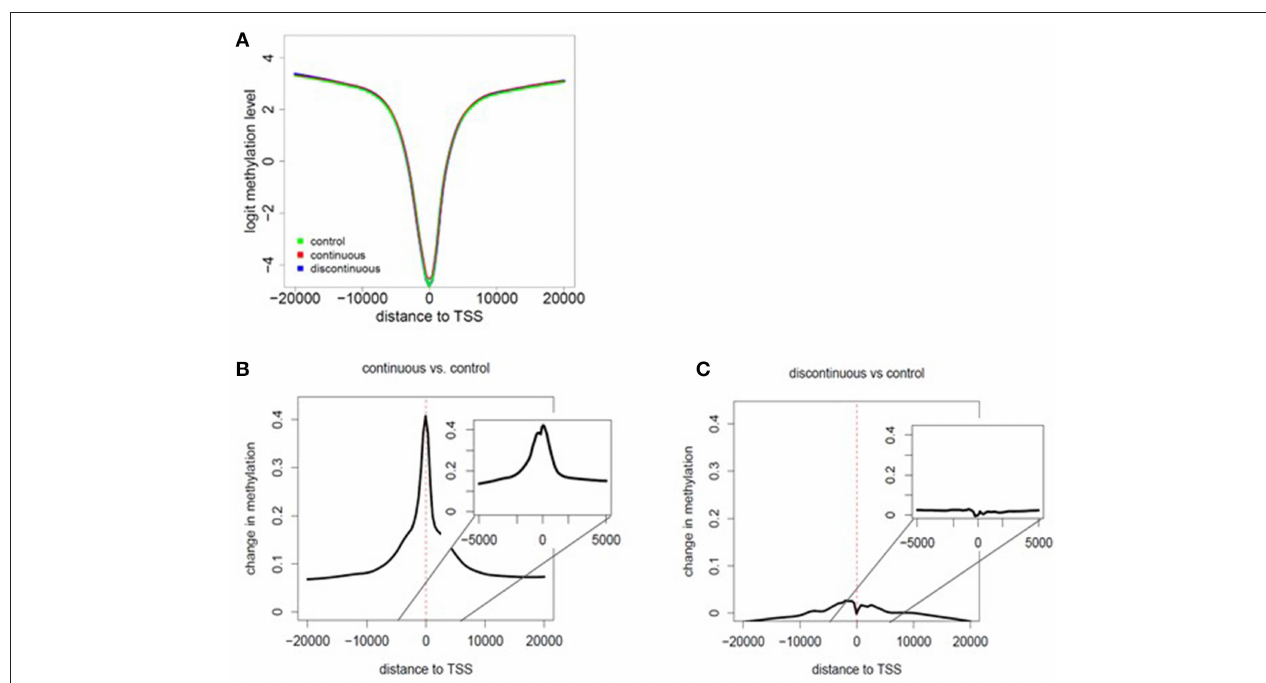
FIGURE 2 | Assessment of global methylation patterns. (A) Methylation levels averaged over all genes were investigated based on the distance to the nearest TSS ( ± 20,000 bp of the TSS for each group). The data in the histogram overlay depicts the methylation level from each exposure group. (B,C) Global changes in methylation with continuous exposure (B) or discontinuous exposure (C) relative to controls are presented in histogram plots. The inset shows the average change in methylation ± 5,000 bp around the TSS. Negative distances correspond to CpG sites downstream of gene TSS. The coefficients of the glmLRT models generated for each comparison were used to assess change in methylation patterns relative to